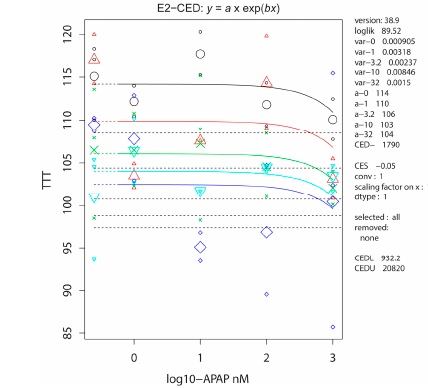
Figure 6. Dose response of antioxidative parameters in the carcass of adult zebrafish exposed to cadmium during early embryonic life (0–72 hpf) after a challenge with APAP. X -axis: APAP concentration; Y -axis: response; CdCl 2 concentration groups are statistically significantly separated and shown as black—0 μ M; red—1 μ M; green—3.2 μ M; dark blue—10 μ M; light blue—32 μ M CdCl 2 at embryonic exposure.